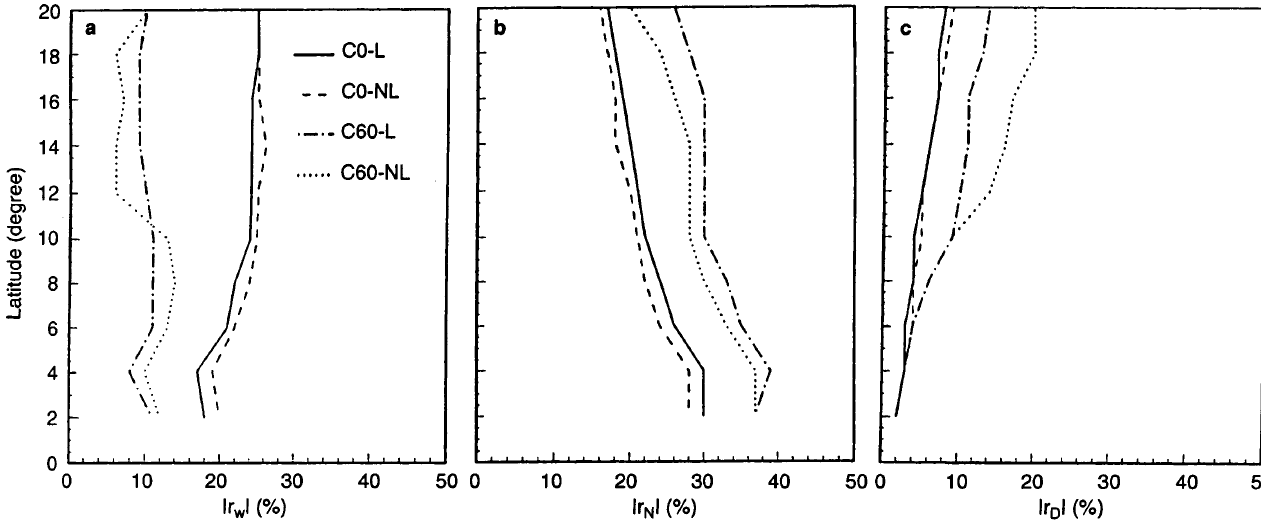
Table 6. Critical latitude values ( h c ) for the meridional ( c (cid:136) 0 (cid:14) ) and non meridional ( c (cid:136) 60 (cid:14) ) boundaries. T = 180 days c = 0